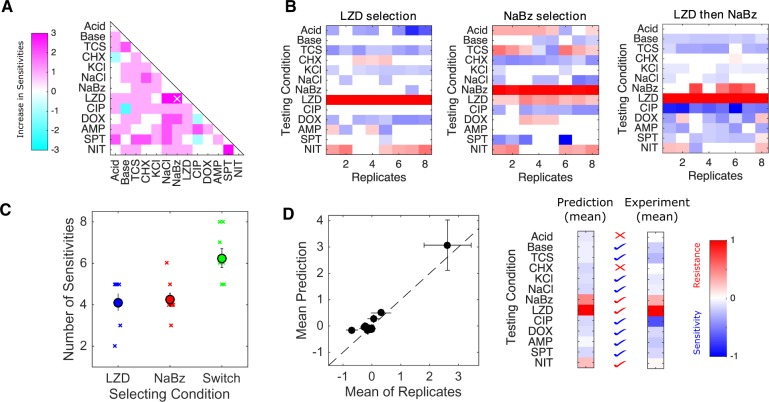
Selection in alternating environments can induce sensitivity to more stressors than selection in single environments. (A) Predicted change in number of sensitivities following sequential evolution using pairs of conditions. Change is positive if sequential evolution is predicted to result in more sensitivities than evolution in either component alone. Predictions assume additivity of (log-scaled) resistance profiles. A sequence of LZD and NaBz (white x) is predicted to give the maximum increase in sensitivities. (B) Resistance profiles for replicate evolution experiments (eight per condition) in LZD only, NaBz only, or a two-step sequence consisting of LZD selection followed by NaBz selection. Resistance (red) or sensitivity (blue) to each condition (rows) is quantified using the (log2-transformed) fold change in the half-maximal inhibitory concentration (IC50) for the selected isolate relative to that of ancestral (V583) cells. (C) Left panel: isolates evolved in the alternating environment (“switch” between LZD then NaBz, green) exhibit sensitivity to more environments than isolates selected in each environment alone (blue and red; P < 0.01, Wilcoxon rank sum test for pairwise comparisons between LZD and switch and between NaBz and switch. (D) Left: scatter plot comparing the mean collateral profile of isolates from the alternating selection (“experiment”) and mean collateral profiles predicted by an average (linear sum) of profiles generated in the single environments (“prediction”). Right panel: heat maps (color scale same as for panel A). Check marks indicate correctly predicted sensitivity (blue) or resistance (red). X indicates incorrect prediction.